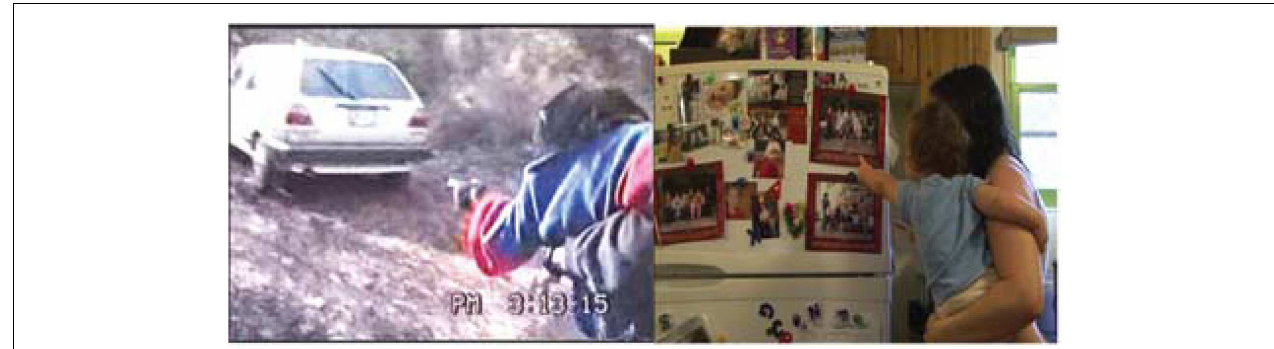
human example – GN (13months, 9days) points at picture on fridge while vocalizing. “What do you see?” Mom asks. “There’s GD in a picture,” Mom